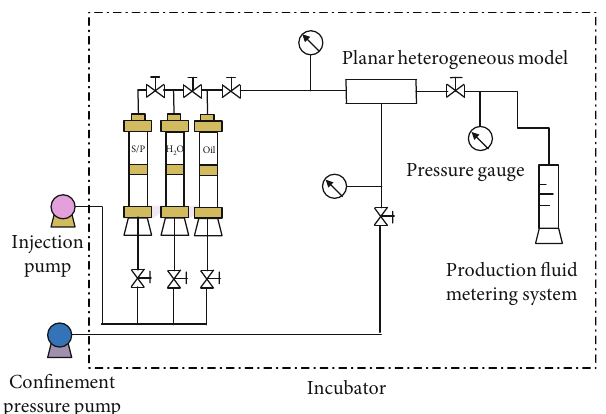
Figure 2: Flow chart of the heterogeneous arti fi cial core